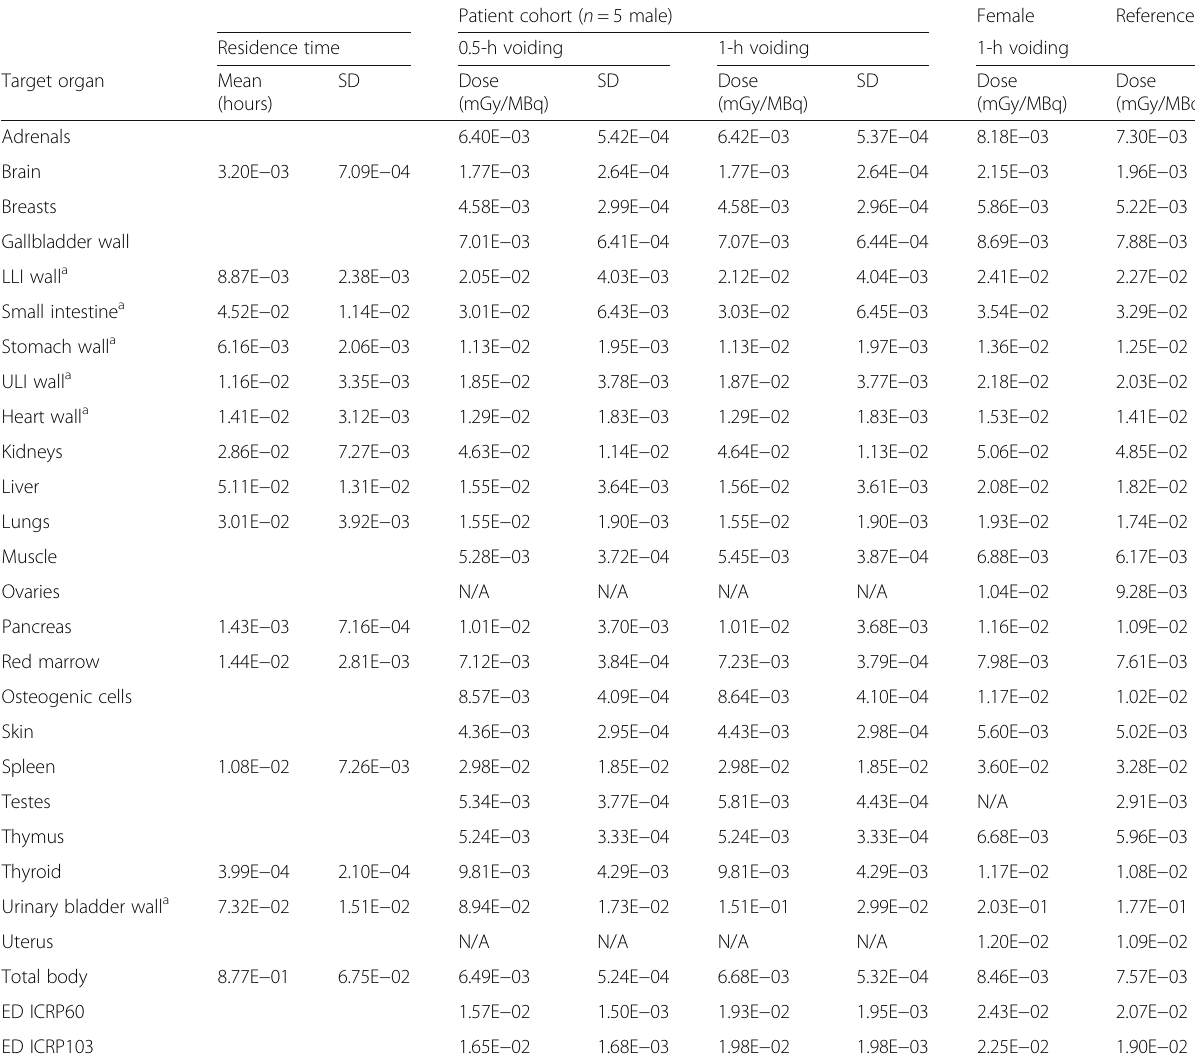
Table 2 Residence times, organ absorbed doses and EDs according ICRP60 and ICRP103 for 30-min and 1-h urinary voiding cycles in men. Extrapolated organ dose in female and defence person is reported for 1-h urinary voiding cycle only